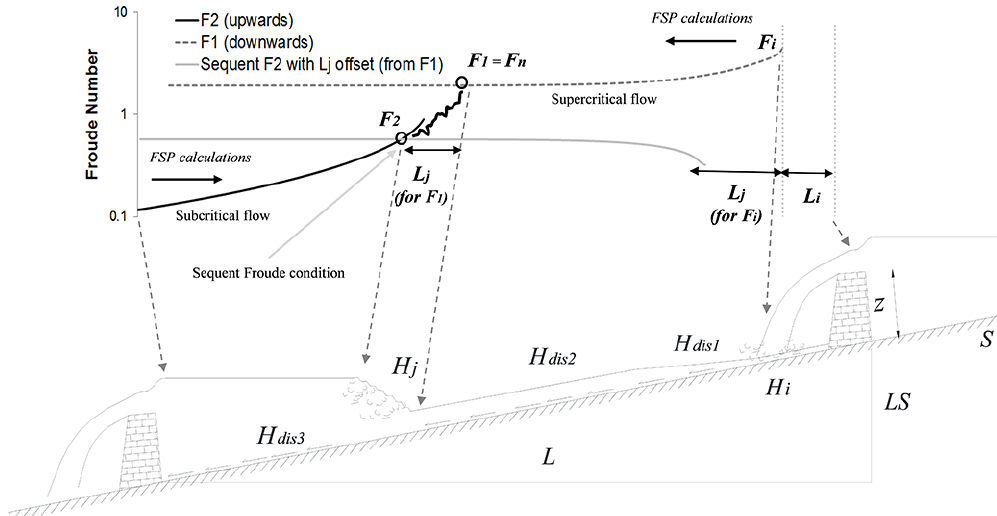
Fig. 2. Energy losses in a controlled gully reach with supercritical normal conditions. At the top, the Froude number profiles are depicted to illustrate the backwater computations methodology. F i represents the Froude number at the impact; F n the Froude number for normal conditions; F 1 the Froude number at the supercritical zone; F 2 the subcritical Froude number; FSP the free-surface profile; H i the energy dissipated at the impact zone; H dis the energy dissipated due to bed friction; H j the energy dissipated at the hydraulic jump; S the gully slope; L the check dam spacing; L i the impact length; L j the roller length; L · S the difference of total head between adjacent check dams; and z the effective check dam